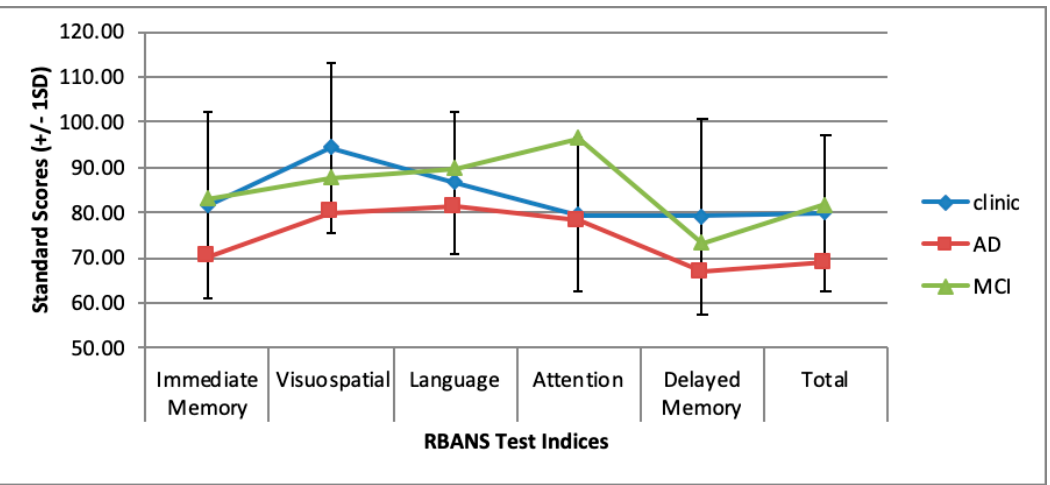
Figure 1. Average RBANS scores of clinic patients against average scores reported in the literature from patients with Alzheimer’s dementia and mild cognitive impairment